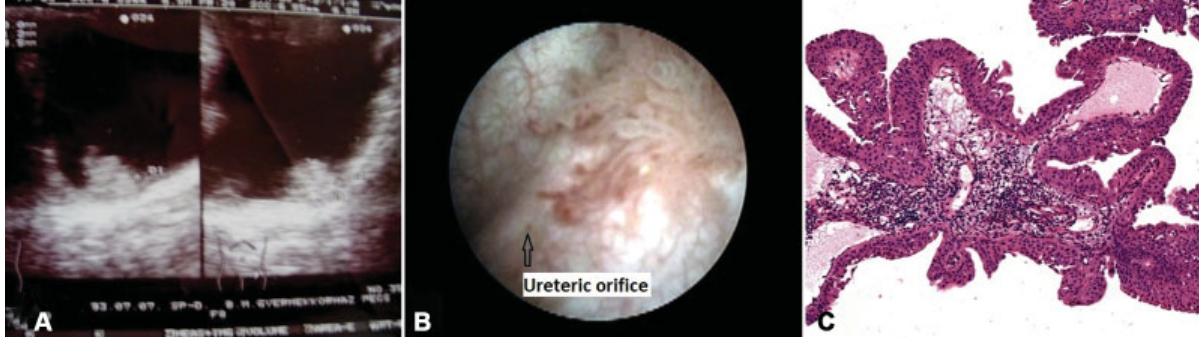
Fig. 1 On ultrasound scan, a 15 (cid:1) 15 mm, solid, hyperre fl ective, solitary lesion was detected in the urinary bladder next to the ori fi ce of the left ureter. ( A ) During urethrocystoscopy, a typical uroepithelial papilloma was detected next to the left ureteral ori fi ce. ( B ). Histological fi nding was uroepithelial papilloma. ( C ) Case